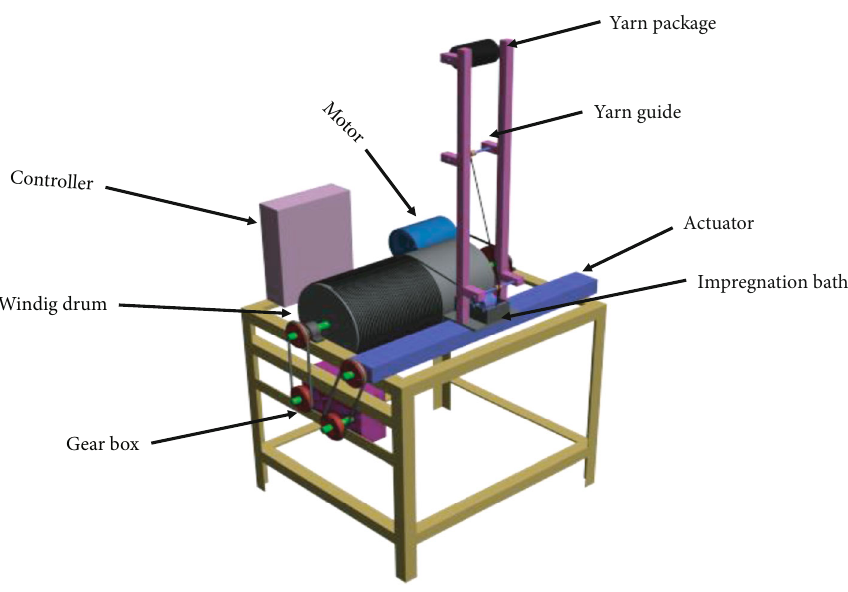
Figure 2: In-house developed lab-scale UD prepreg composite manufacturing setup [28].